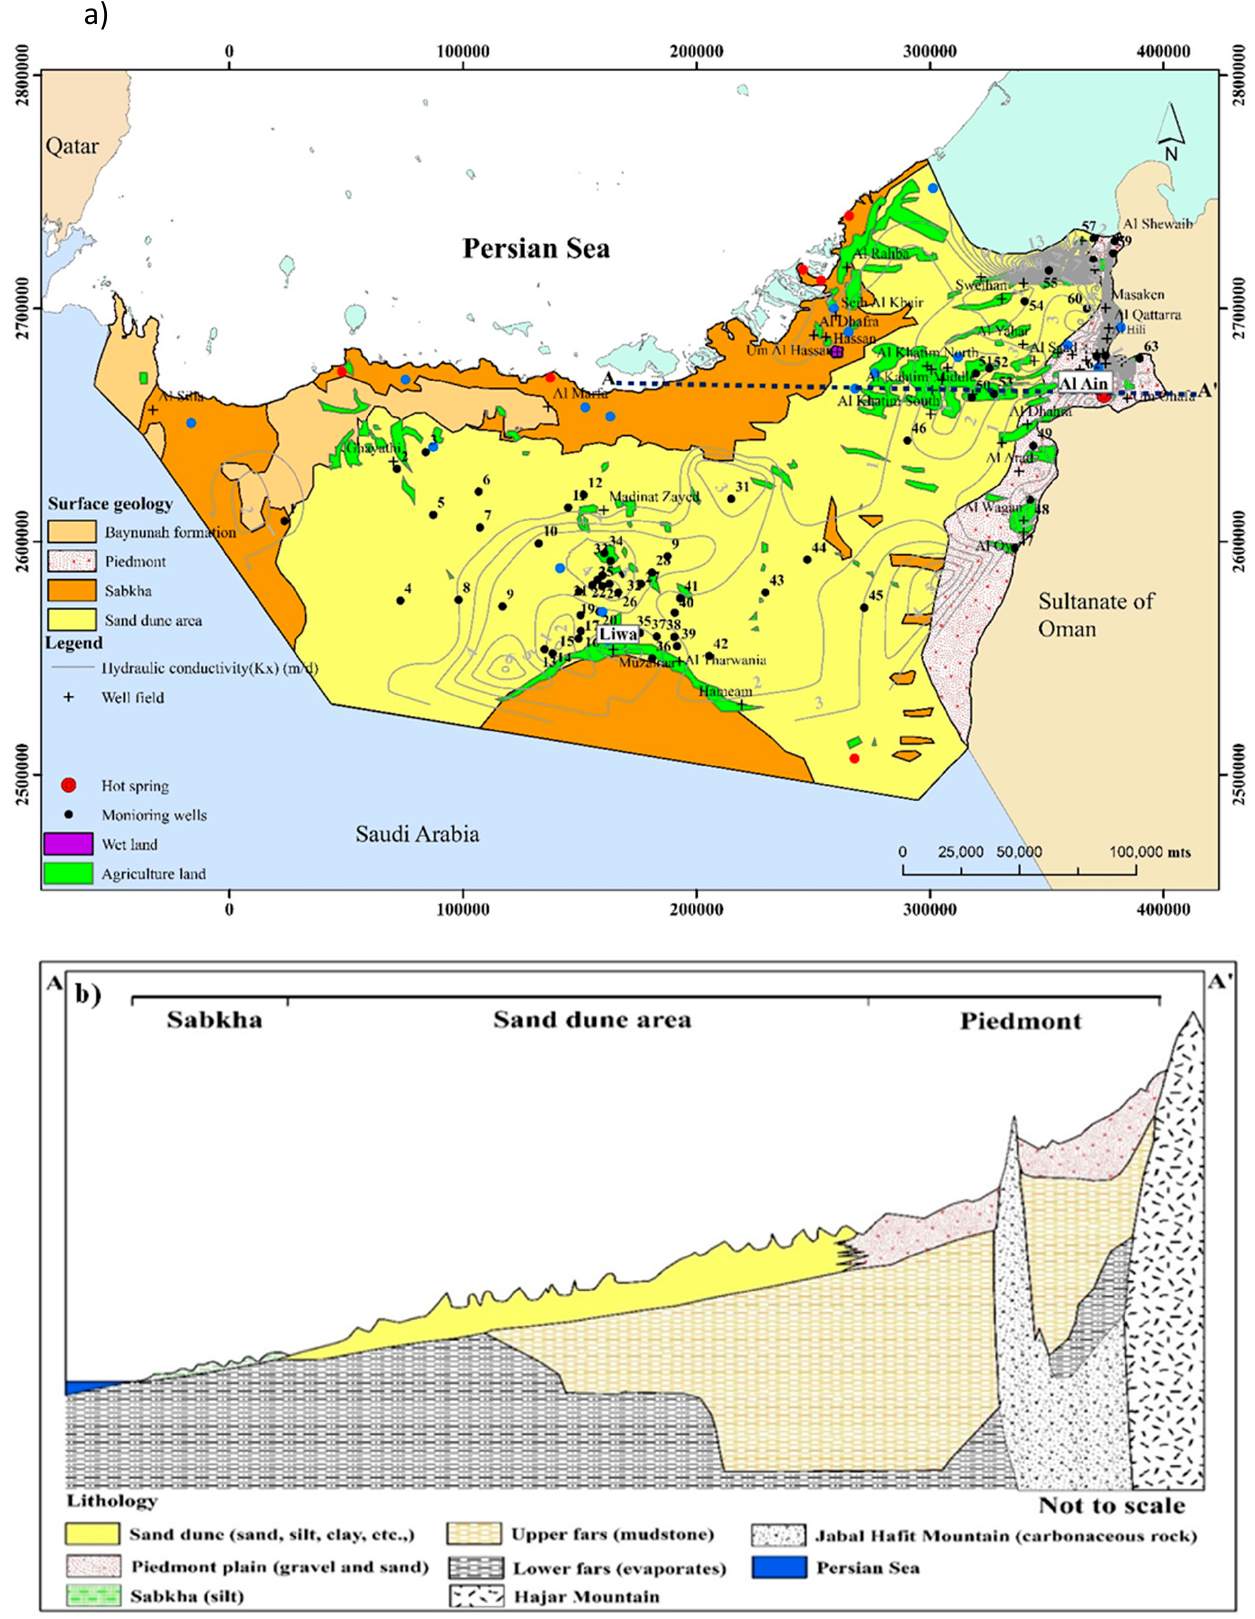
Figure 1. ( a ) Location of the study area, agriculture activities (a major groundwater consuming sector), spatial geological setting and location of monitoring well, desalination plant and TSE plant; ( b ) geological cross-section of the study area. The elevation varies from 0 m above mean sea level (AMSL) at the coastal boundary to 1163 m AMSL at the Jabal Hafit Mountain located at the eastern sector. The spatial